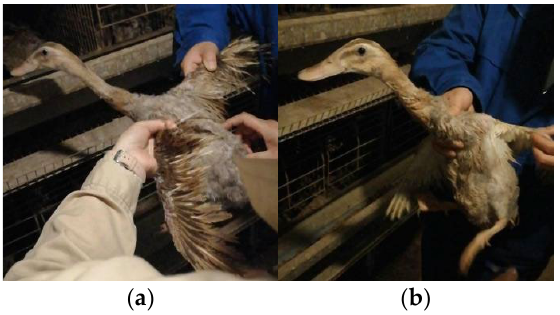
Figure 1. Picture of damaged feathers of cage-reared laying ducks. ( a ) back feather display, ( b ) neck feather display.